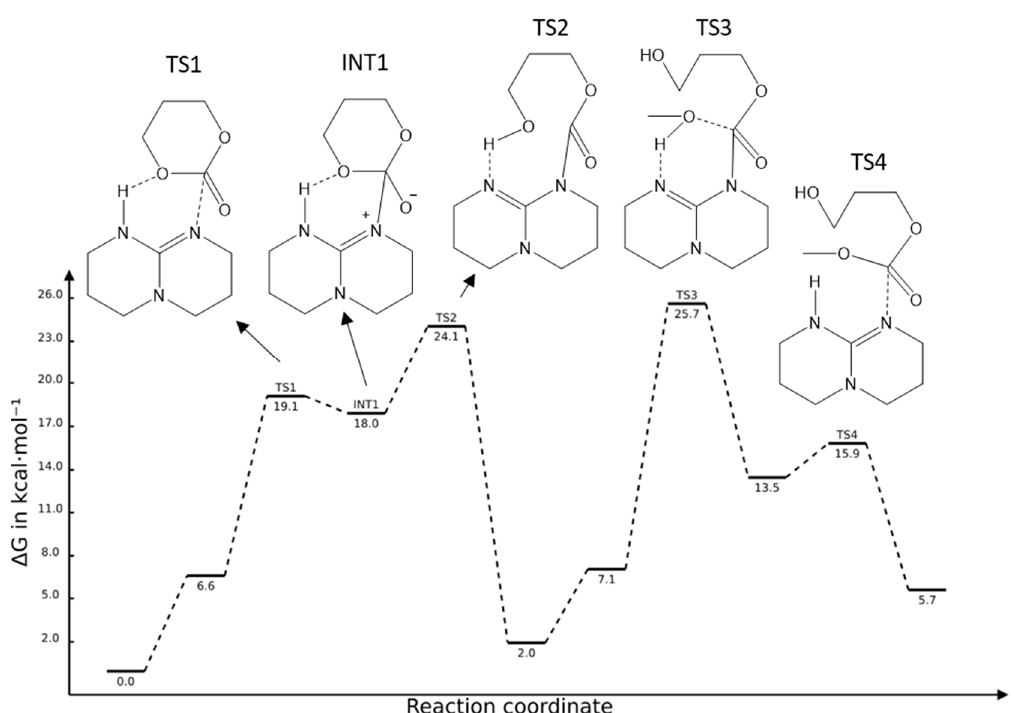
Scheme 4. Free energy profile for the nucleophilic mechanism of the TBD catalysed ring-opening polymerization of